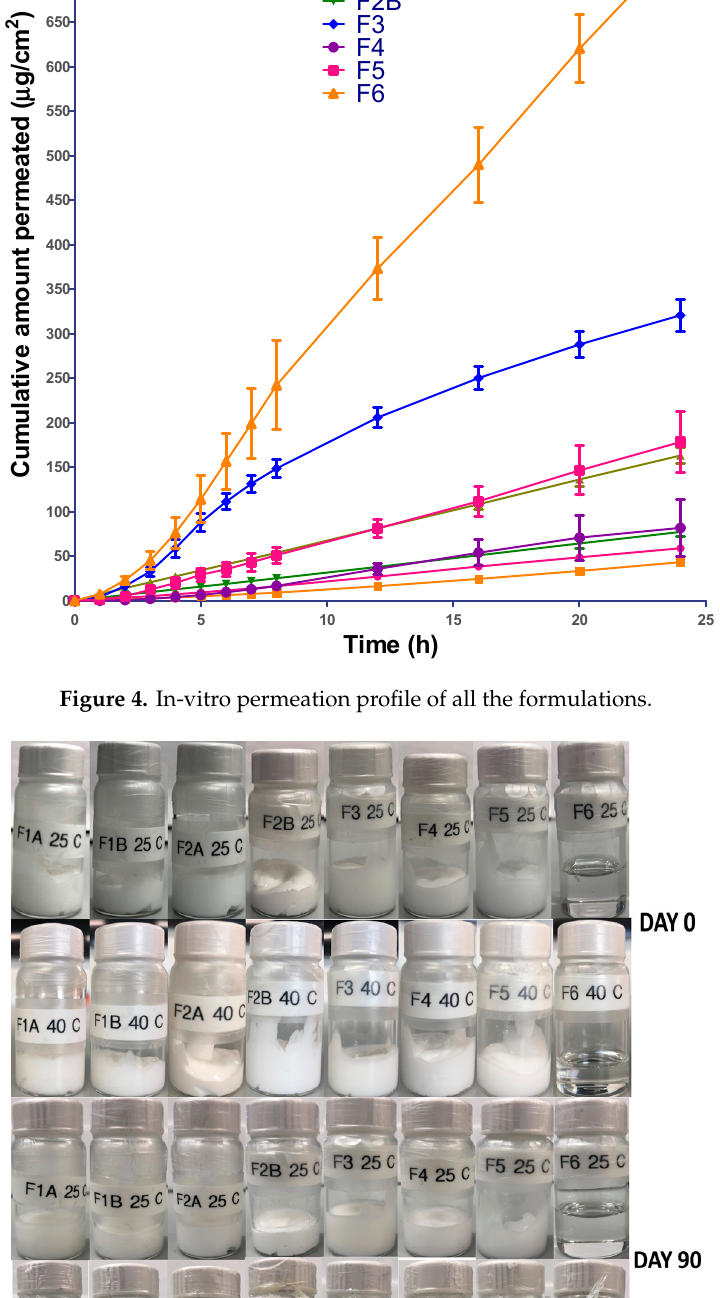
Figure 5. Physical stability of creams and gels at 25 and 40 °C.